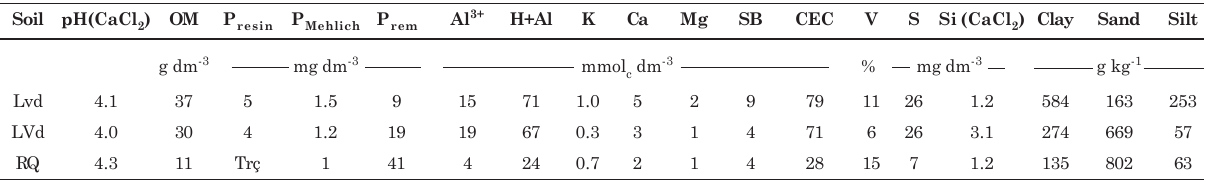
Lvd: dystroferric Rhodic Hapludox (Oxisols); LVd: dystrophic Rhodic Hapludox (Oxisols); RQ: dystrophic Typic Quartzipsamment (Entisol).